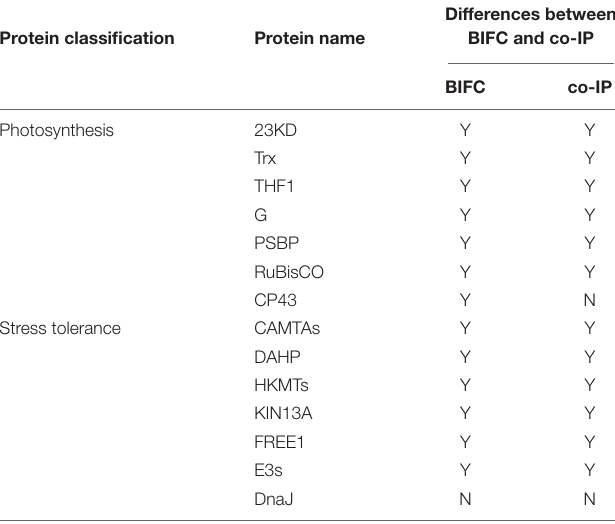
TABLE 2 | Comparison between the bimolecular fluorescence complementation (BIFC) and co-immunoprecipitation (co-IP) assays in terms of the interactions between Cry1Ab/c and 14 endogenous proteins involved in photosynthesis and stress